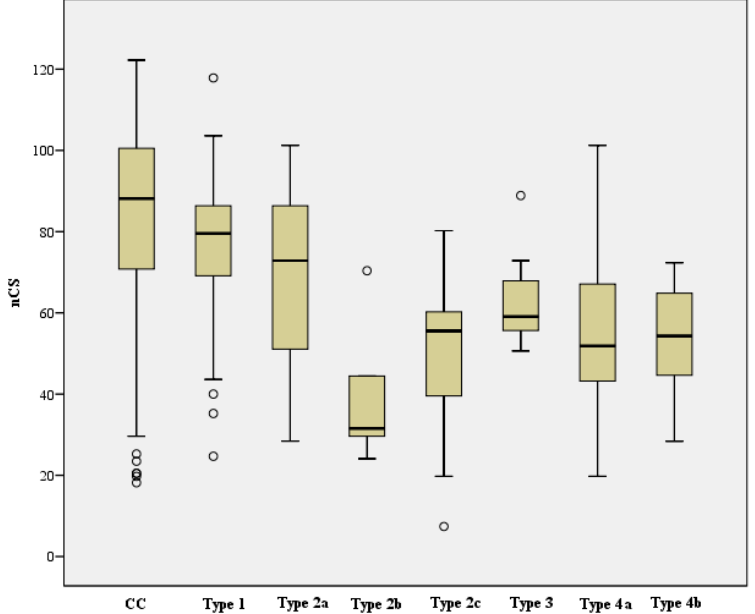
Figure 23. Comparison nCS of collective without complications and complication types (X-axis: study collective, Y-axis: median, IQR, extreme values, outliers).